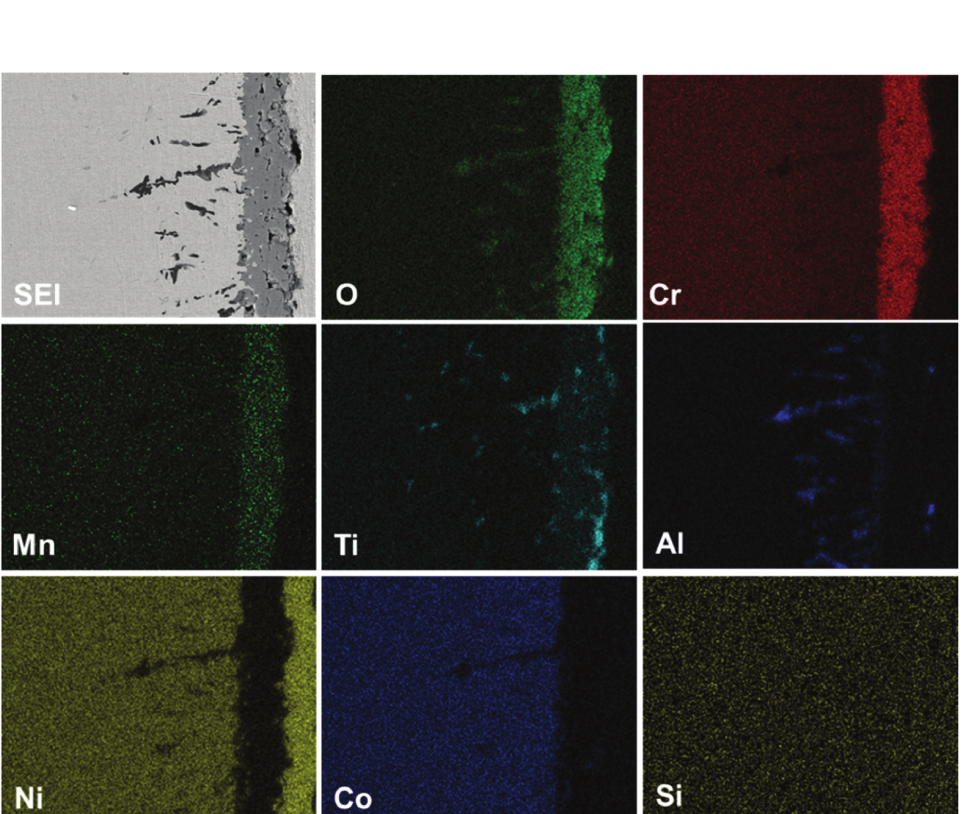
Figure 5: Element map- ping of Inconel 740H after oxidation in static air at 750°C for 1,000